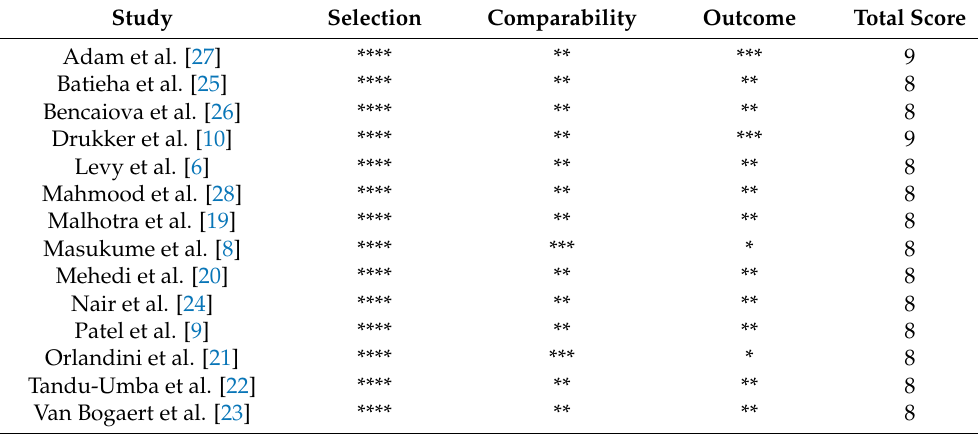
Figure 1. Flow diagram showing the number of articles identified in the systematic review and meta-analysis of maternal anaemia and caesarean delivery. Table 1. Newcastle-Ottawa Scale rating for included studies: (* indicates the number of the star for each criterion, Maximum score = 9